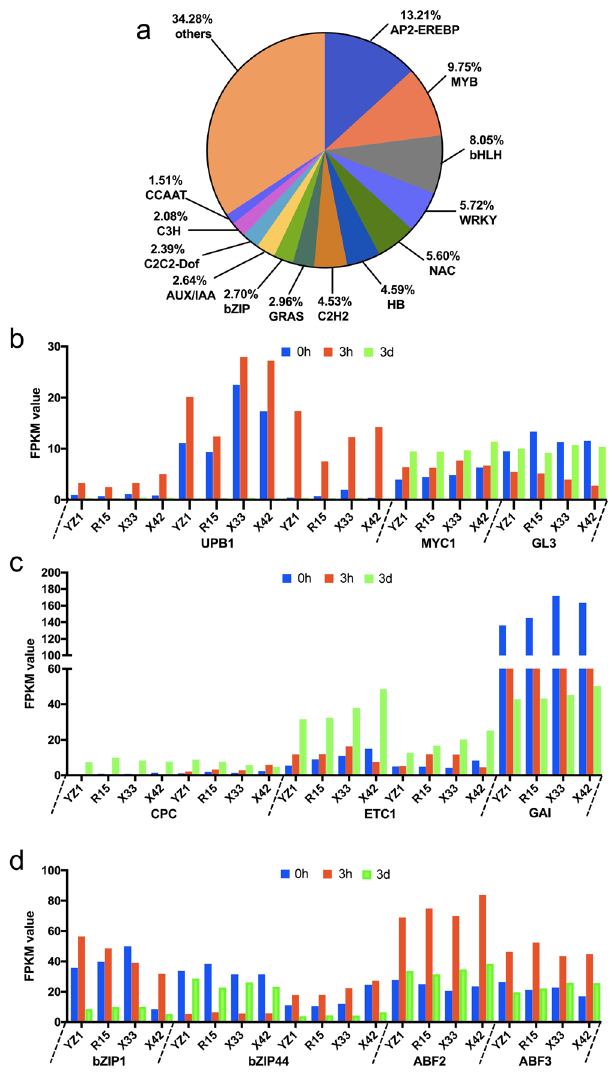
Figure 4. ( a ) TF genes and classification of TF families. TF genes were classified into TF families using iTAK. A total of 1590 different transcription factors were annotated in 69 TF families. Numbers represent the percentage of TF genes. ( b – d ) Detailed expression profiles of SE differentiation related TF genes. The x-axis indicates the distribution of SE differentiation related TF genes in the four cotton species, and the y-axis represents the value of FPKM in each TF